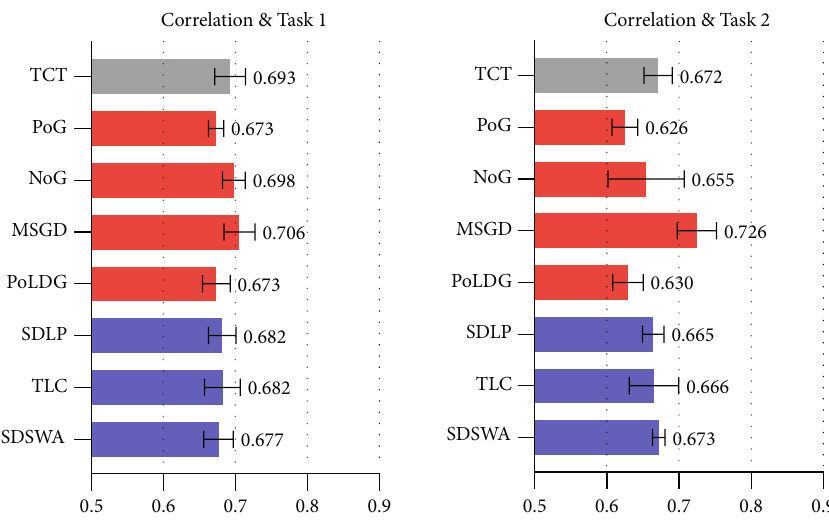
Figure 14: The interaction between interaction mode and speed in SDSWA.